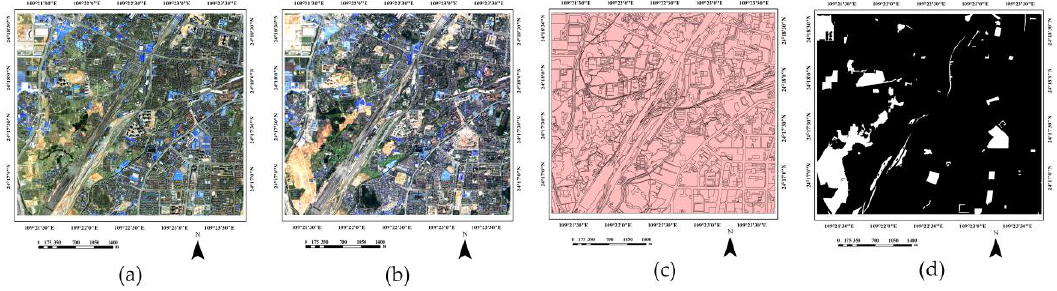
Figure 7. The second experimental dataset (DS2). ( a ) Image acquired on 13 April 2015; ( b ) image acquired on 11 May 2016; ( c ) HVM in 2015; ( d ) reference image.